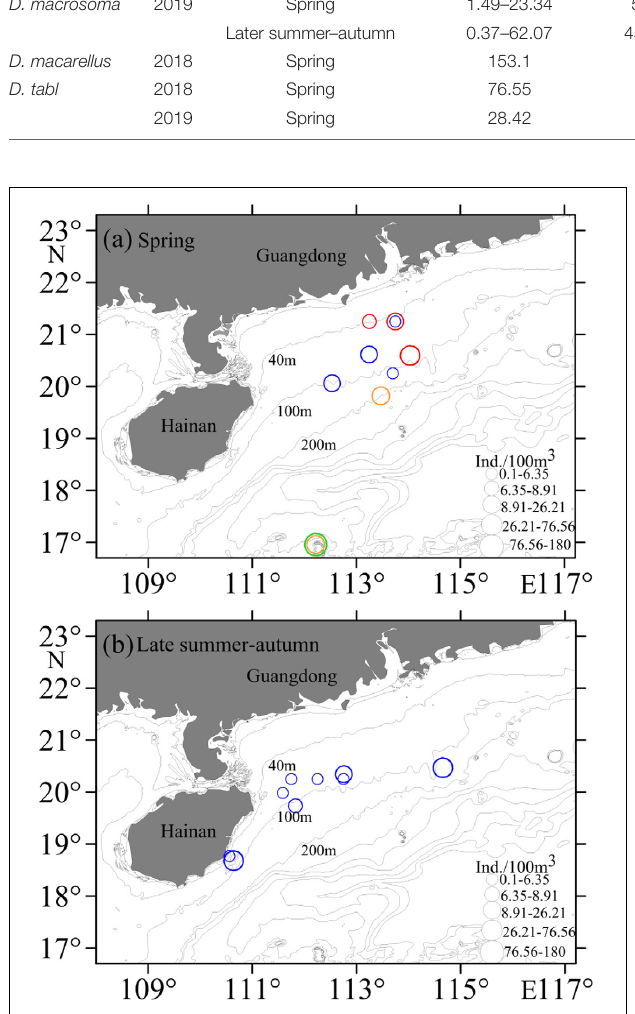
FIGURE 7 | Horizontal distributions of Decapterus eggs in the northern South China Sea. (a) Spring; (b) Late summer-autumn. Symbols represent catch rates per 100 m 3 . Red circles indicate D. maruadsi , blue circles indicate D. macrosoma , green circles indicate D. macarellus , and orange circles indicate D. tabl